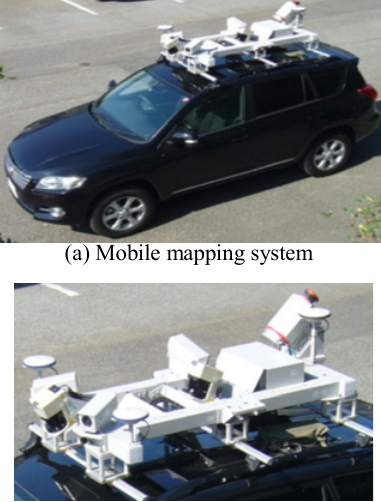
Figure 1. Mobile mapping